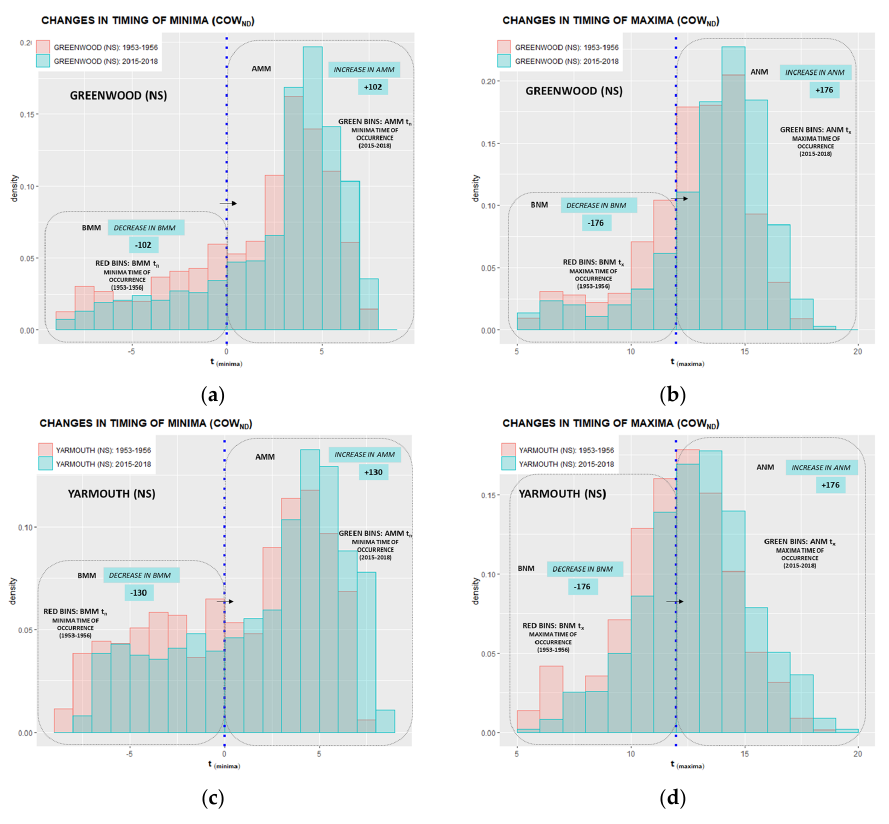
Figure A19. Atlantic Canada climate region: Greenwood (NS) and Yarmouth (NS). Time evolution of the Diurnal Extrema Timing (DET) histograms at Greenwood ( a , b ), and Yarmouth ( c , d ) stations. Migration of the Before Midnight Minima (BMM) to After Midnight Minima (AMM) and migration of the Before Noon Maxima (BNM) to After Noon Maxima (ANM) between four-year averages at the beginning (1953–1956) and ending (2015–2018) of data ranges. The blue dotted line represents midnight delineation ( left ) and noon delineation ( right